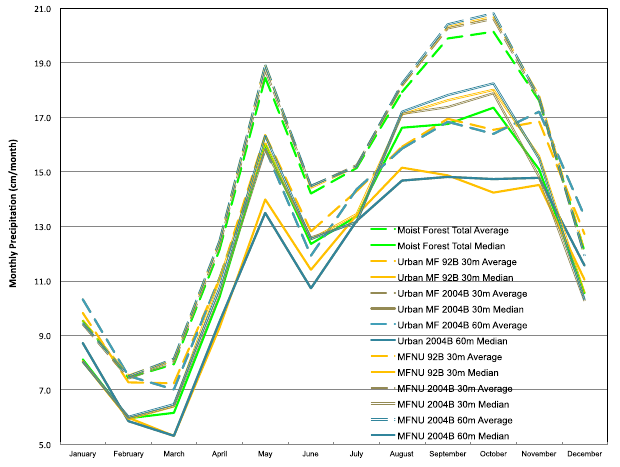
Figure 9. Monthly average and median precipitation for the moist forest urban B and non-urban.